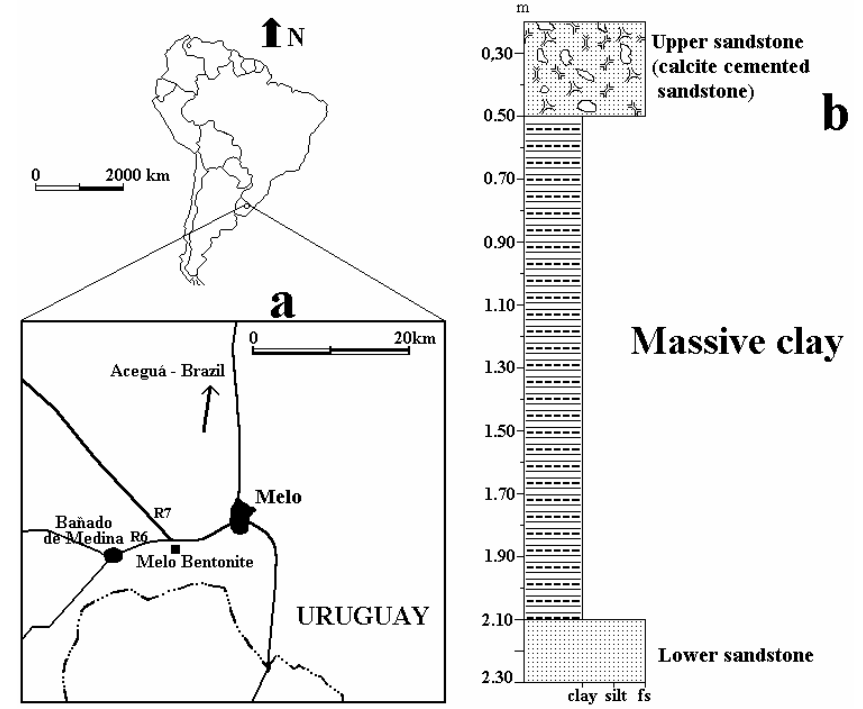
Fig. 1 – The geological setting of the bentonite bed from Melo (Uruguay). a) Location of the studied quarry. b) The studied